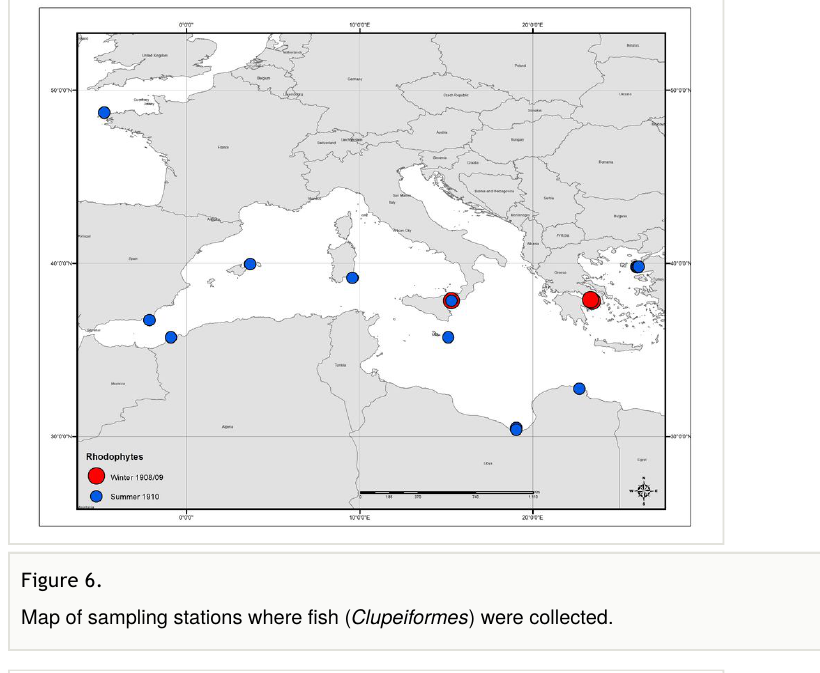
Map of sampling stations where fi sh ( Clupeiformes ) were collected.